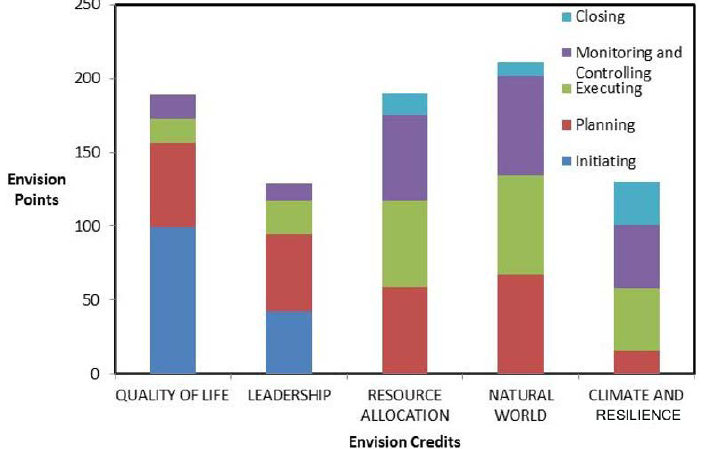
Figure 5. Mapping project management processes and sustainability performance measures.